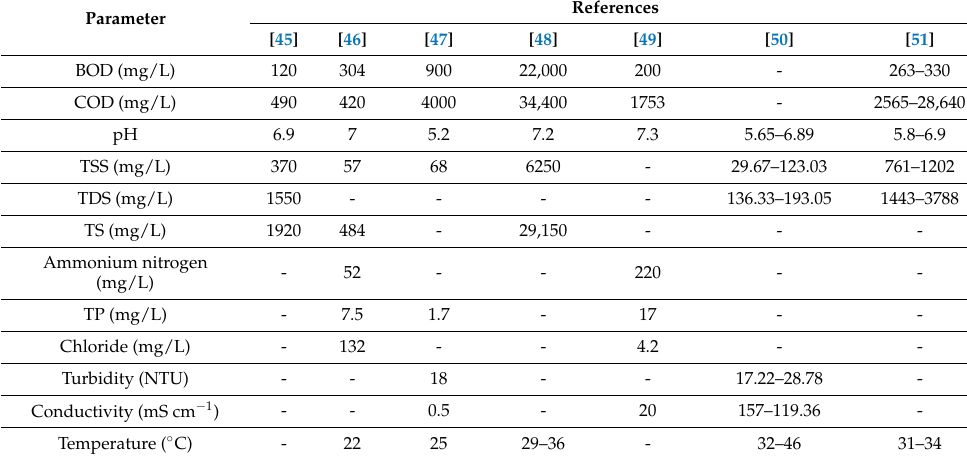
Table 2. Range of parameters in different PWW .